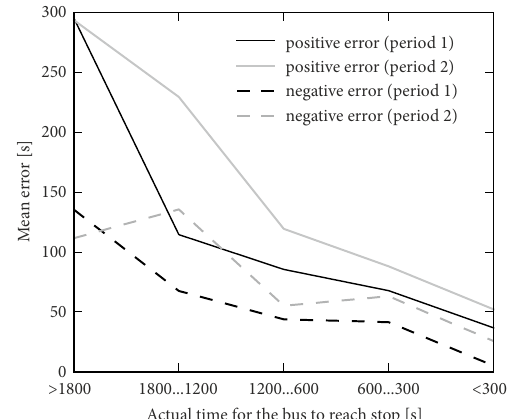
[s]>1800 1800...1200 600...3001200...600 Actual time for the bus to reach stop Figure 11. Mean error values v/s actual time for the bus to reach stop